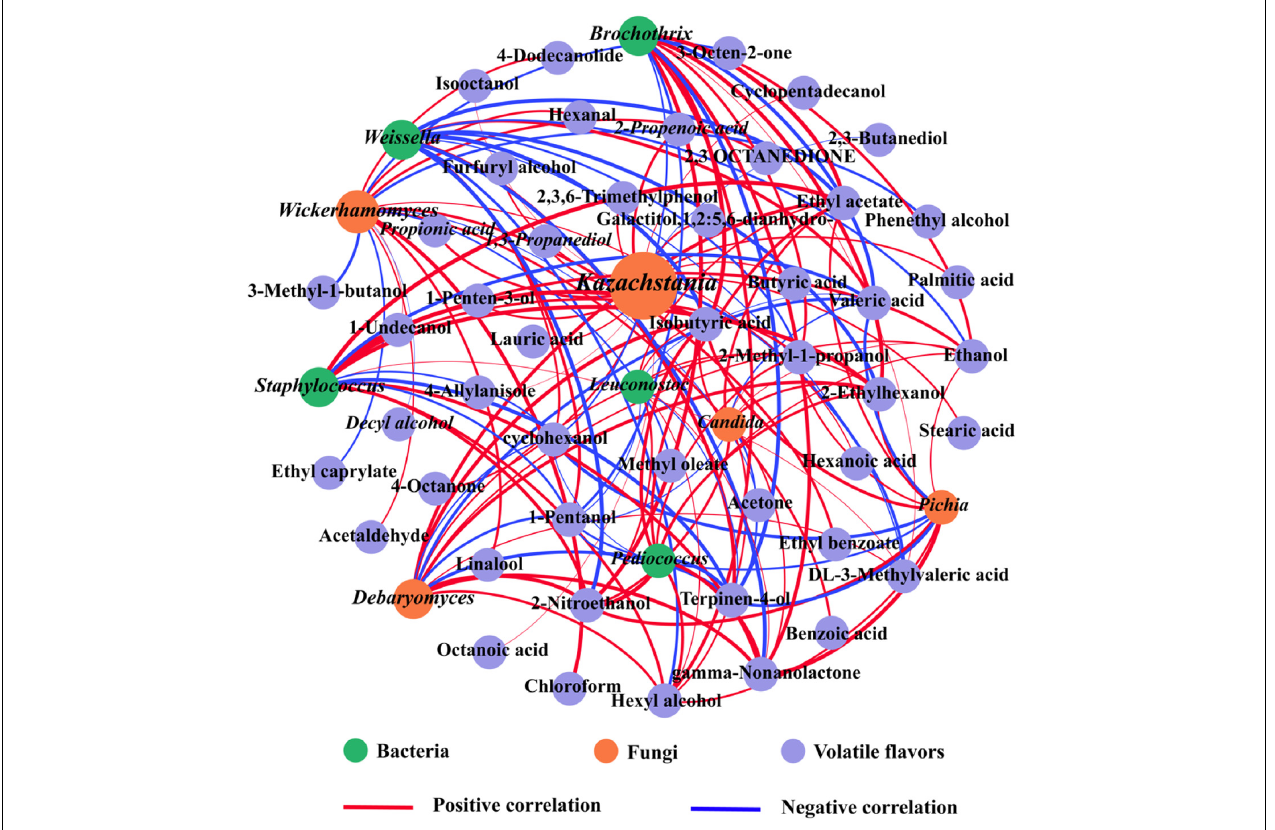
FIGURE 8 | Correlation analyses between microorganisms [VIP(pred) > 1.0] and volatile flavor compounds. Statistically significant ( P < 0.05) Pearson’s correlation coefficient (| ρ | > 0.8) indicates the robust correlations. The green, orange and purple circles refer to bacteria, fungi and volatile flavors, respectively, and the red and blue lines refer to positive correlations (| r | > 0.8 and P < 0.05) and negative correlations (| r | < − 0.8 and P < 0.05), respectively. The size of nodes indicates the degree of connections. The thickness of each connection (edge) between two nodes is proportional to the value of Pearson’s correlation coefficient. (For interpretation of the references to color in this figure legend, the reader is referred to the web version of this